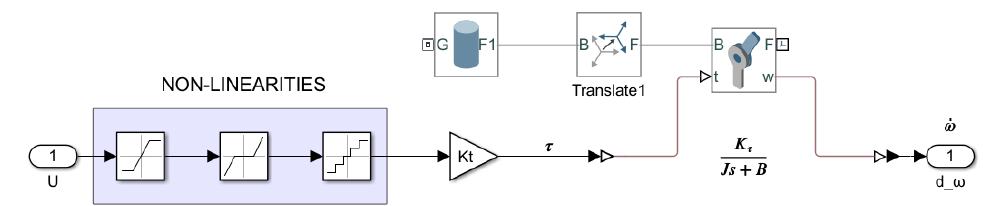
Figure 2. Simscape wheels-on-the-air simulation